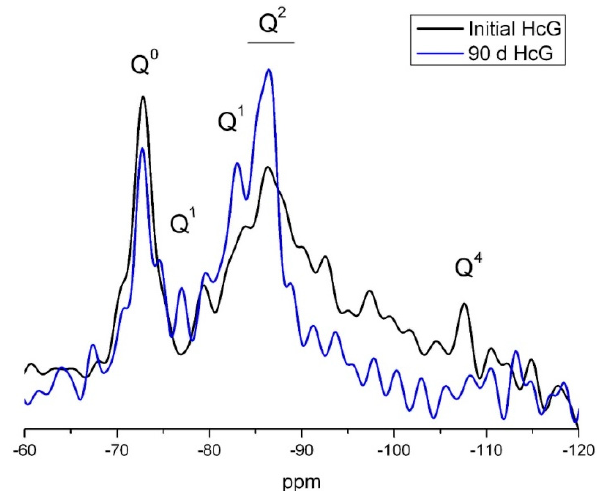
Figure 15. 29 Si NMR spectrum for 0 day and 90 days HcG waste.